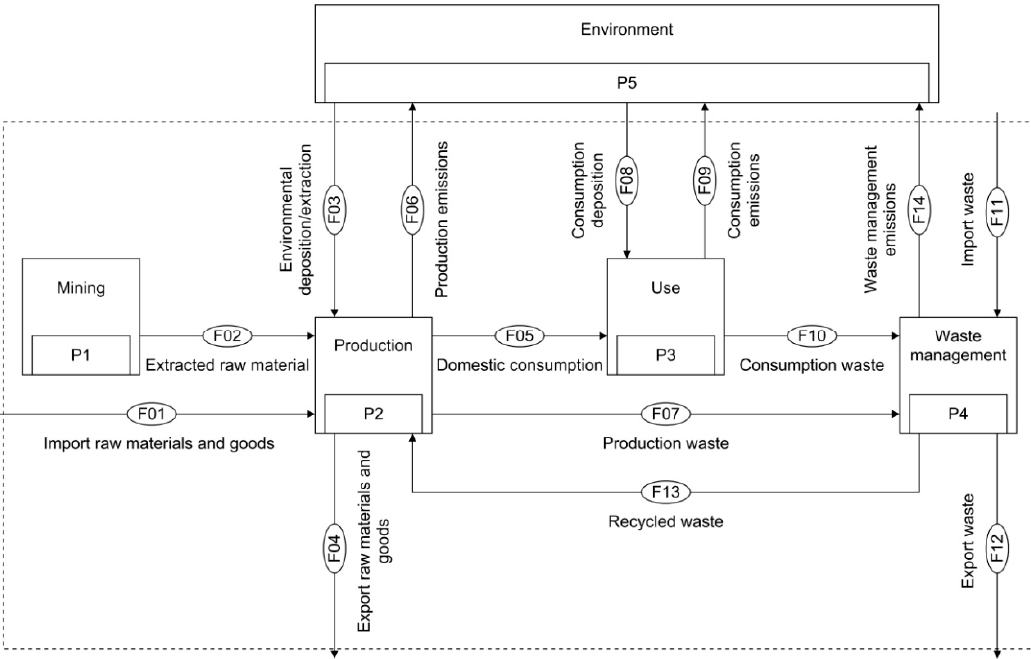
Figure 5. Generic MFA system. The dashed line marks the system boundaries.